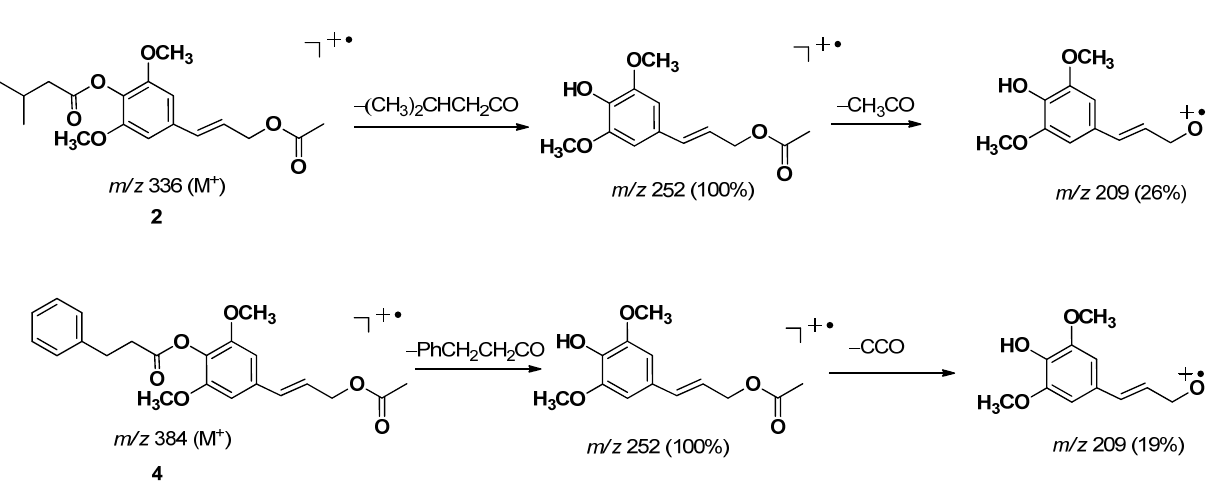
Figure 3. EIMS fragment ions of 2 and 4